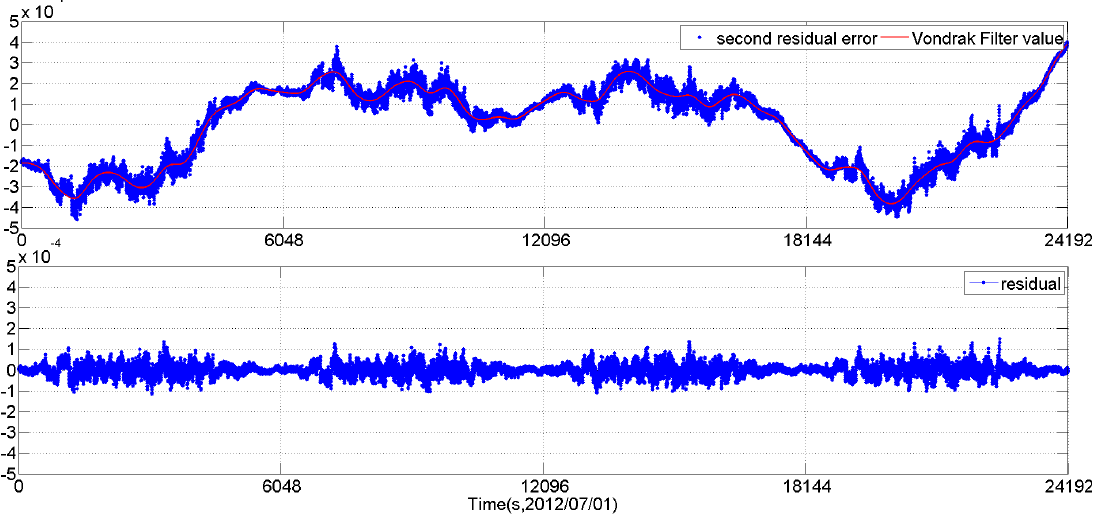
Figure 3. The Vondrak filter results of the q 0 element of CCD01 quaternion data.